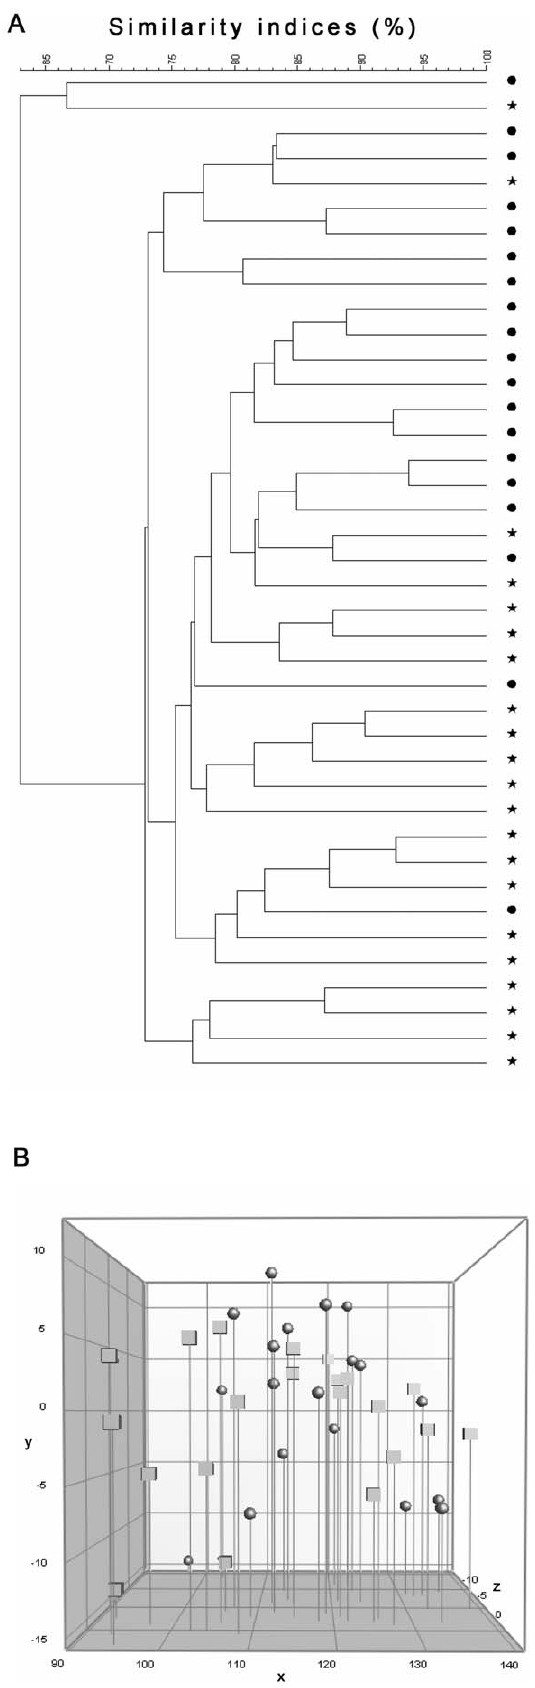
Figure 3. Dendrogram and Principal Component Analysis (PCA) based on Denaturing Gradient Gel Electrophoresis (DGGE) profiles from caecum samples. A) Dendrogram based on DGGE profiles of PCR amplified 16S rRNA V3 gene region from caecum samples collected from the NOD/Bom mice included in the incidence study. The dendrogram was made using Dice’s similarity coefficient and Unweighted Pair Group Method with Arithmetic mean (UPGMA). The scale bar represents the similarity index in percent (100% indicate complete similarity 0% indicate complete dissimilarity). Similarities beyond 92% are defined as being incidental illustrated with a cut of line at 92%. Caecum sample analysis from each individual mouse is marked with either a dot or a star. Stars represent mice from the group of animals treated with 5% ethanol in the drinking water and dots represent mice from the control group receiving pure drinking water. B) Three-dimensional PCA based on DGGE profiles of PCR amplified 16S rRNA V3 gene region from caecum samples collected from the NOD/ Bom mice included in the incidence study. Caecum samples representing the individual mice are marked with either a dot or a square. Squares represent mice treated with 5% ethanol in the drinking water and dots represent mice receiving pure drinking water. No grouping according to treatment was